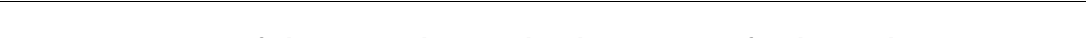
Table 1. Summary Table of Direct-marketing Questions in the Census of Agriculture in 2012 and 2017 Market